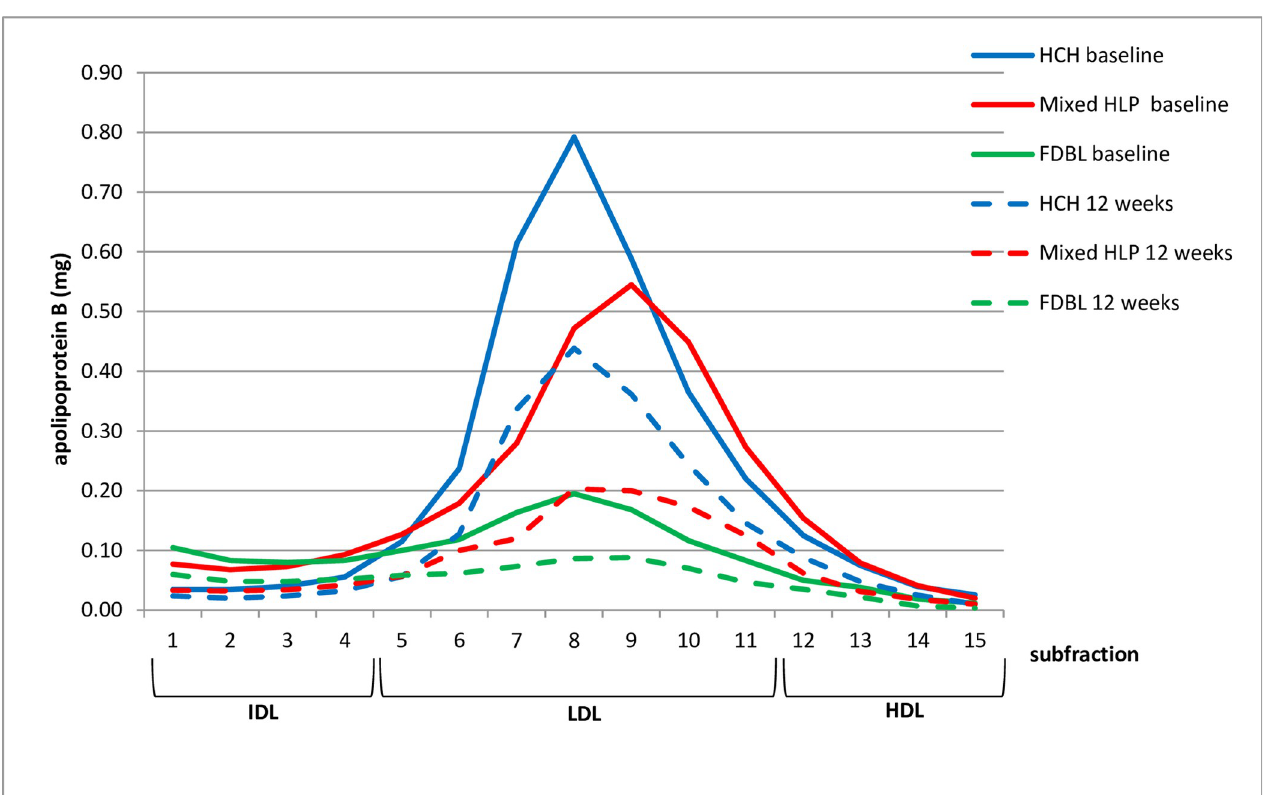
Fig 3. ApoB content (means) in different lipoprotein subfractions before (baseline, solid line) and after 12 weeks (dashed line) of PCSK9 inhibition. Different colors indicate different patient groups. HCH, hypercholesterolemia; mixed HLP, mixed hyperlipidemia; FDBL, familial dysbetalipoproteinemia.